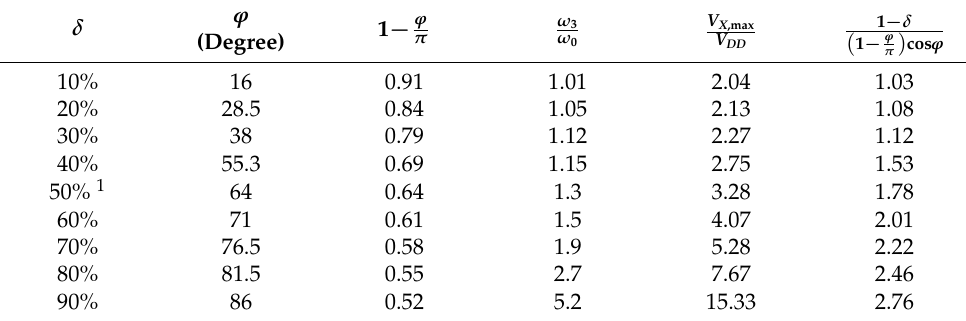
Table 1. Lookup table for various parameters versus the duty